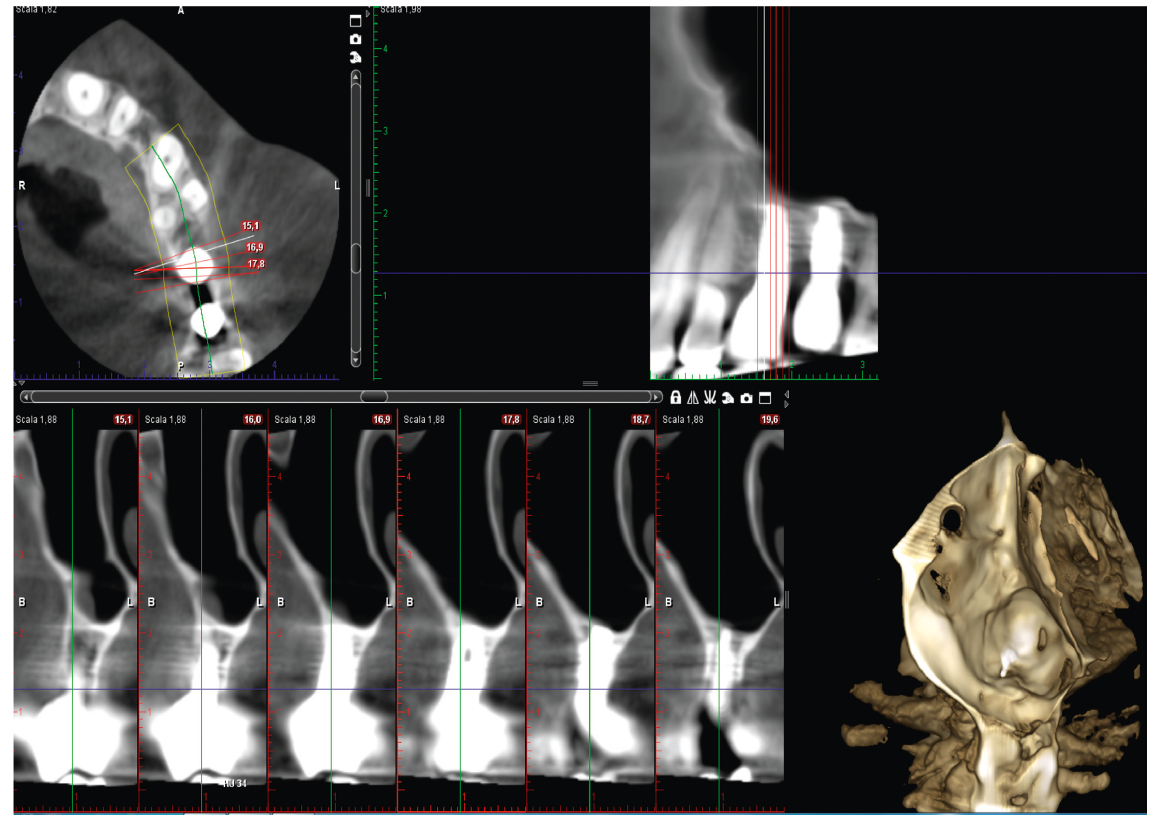
Figure 7: Implant site #25 CT scan at 4